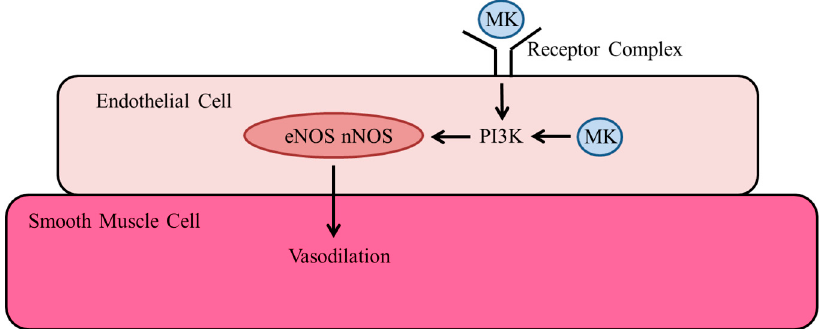
Figure 4. Proposed model for the function of MK to promote vasodilation. Upon binding to a receptor complex, MK activates NOS via the phosphoinositide 3-kinase (PI3K)/Akt pathway. However, MK located in endothelial cells might also contribute by directly activating this signal transduction cascade. Adapted from Lautz et al. 2018 [76].